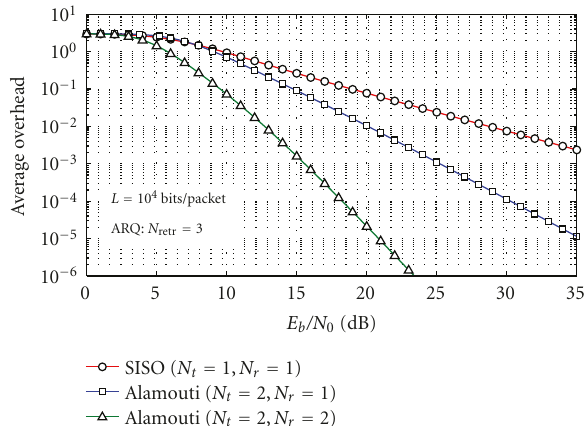
Figure 10: Average transmission overhead E [ovh] from ARQ with maximum 3 retransmissions.